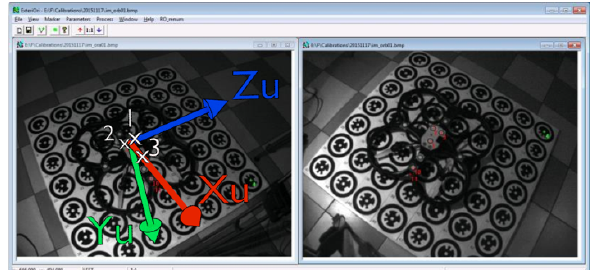
Figure 5. Orientation of the UAV coordinate system with respect to the UAV frame and circular targets. The UAV lies upside down, the bottom side is visible